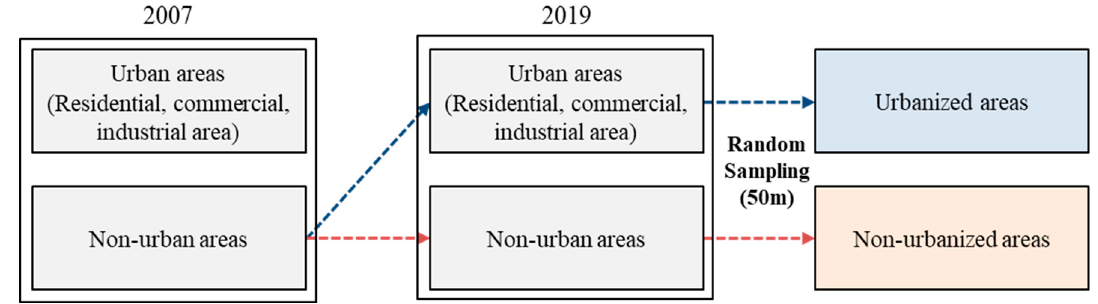
Figure 2. Classification of urbanized and non-urbanized areas.